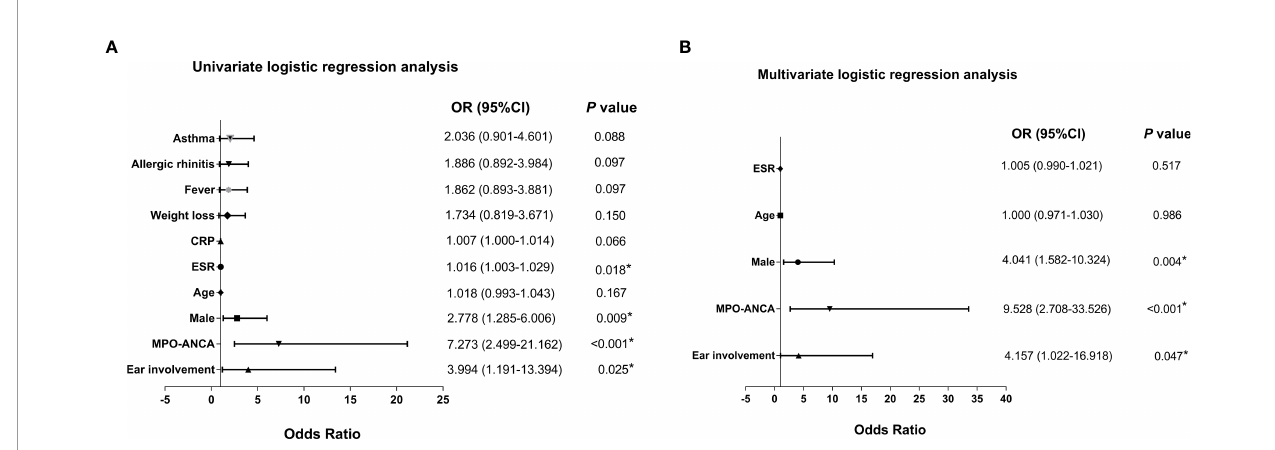
FIGURE 2 | Forest plots of univariate and multivariate logistic regression analysis of renal involvement of patients with EGPA. Forest plots of (A) univariate and (B) multivariate logistic regression analysis of patients with EGPA with renal involvement. ANCA, antineutrophil cytoplasmic antibody; CRP, C-reactive protein; EGPA, eosinophilic granulomatosis with polyangiitis; ESR, erythrocyte sedimentation rate; MPO, myeloperoxidase; OR, odds ratio. * P < 0.05.